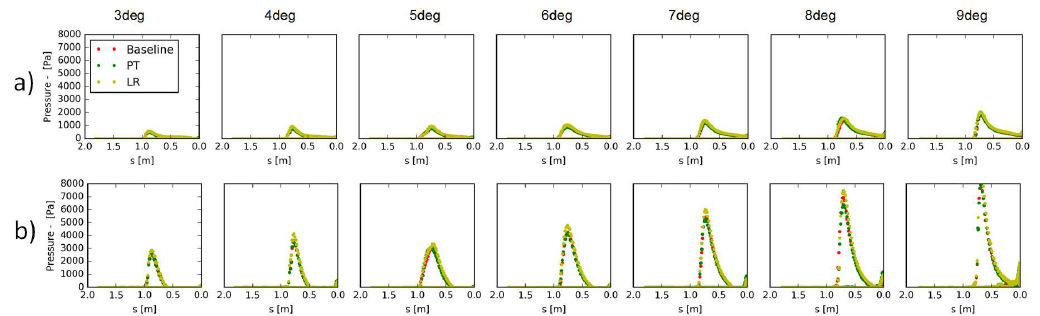
Figure 3. Pressure on the middle line of the surfboard bottom. Baseline in red ( ■ ) and PT in green ( ♦ ) and LR in yellow ( ♦ ) for 4m/s ( a ) and 8m/s ( b ).